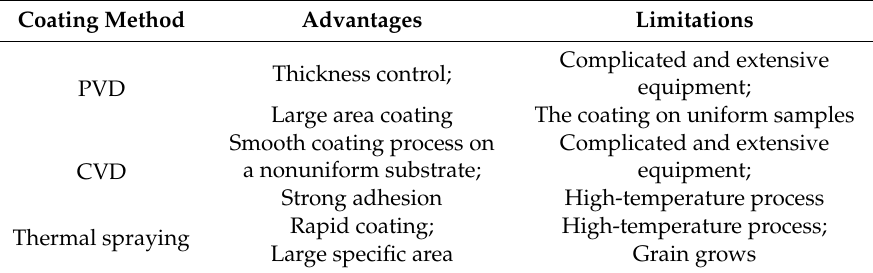
Table 7. Advantages and limitations of the film coating methods